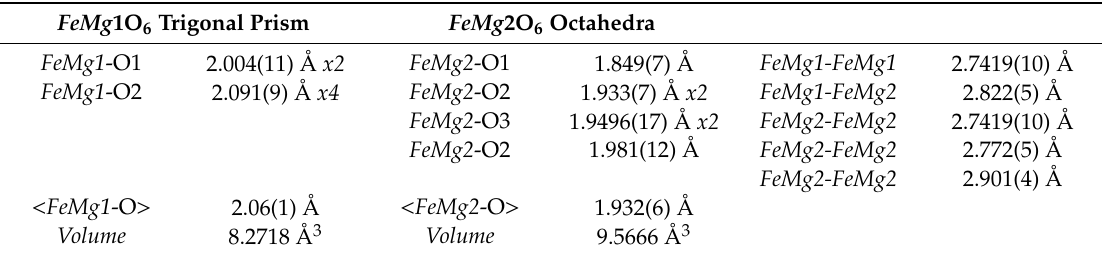
Table 5. Bond distances and polyhedral parameters for hp-(Mg,Fe) 3 O 4 at 30.0(5)